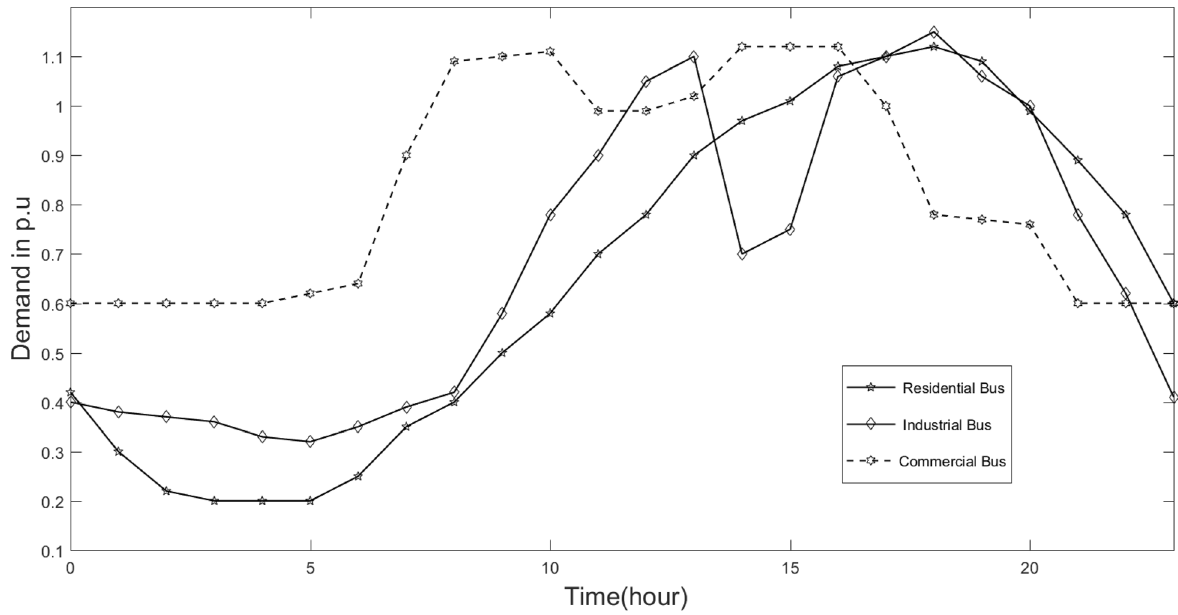
Fig. 3 Daily load pattern of different types of buses